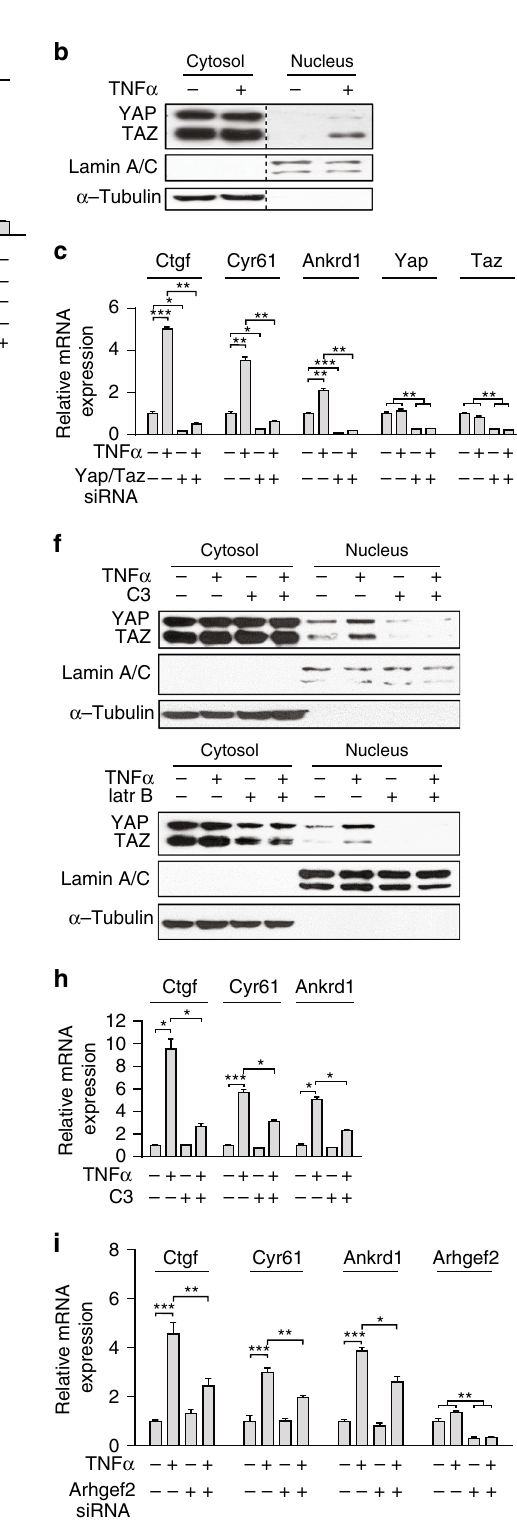
nuclear localization, inhibition of JNK activation had no effect (Figs. 5f and 6c, and Supplementary Fig. 5g), indicating that JNK does not regulate YAP/TAZ function on the level of nuclear translocation. As the YAP/TAZ/TEAD complex has been shown to functionally interact with AP-1 that synergistically regulates YAP/TAZ target gene expression 47 , and as JNK phosphorylates and regulates c-Jun, a component of AP-1 48 , we tested whether